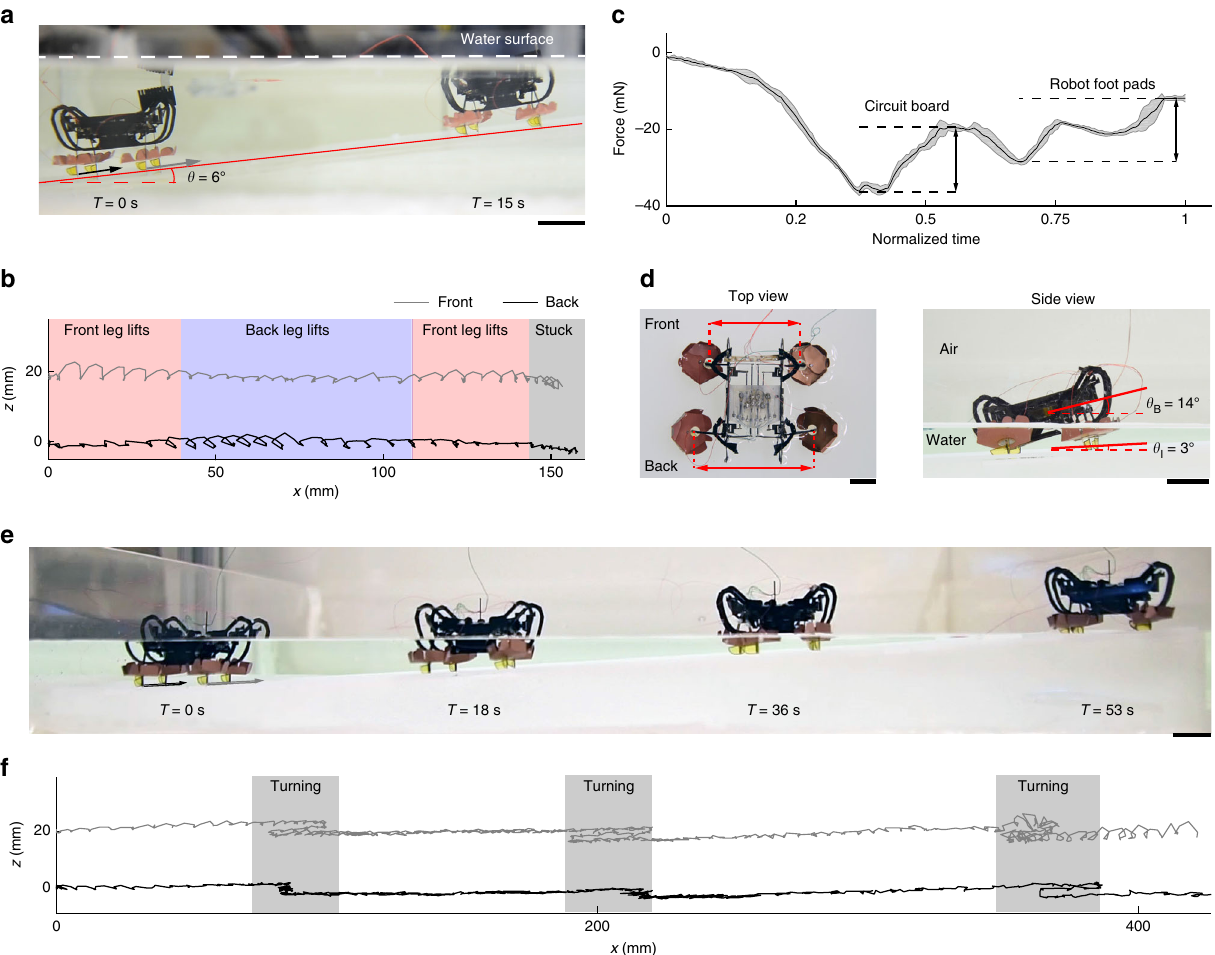
Fig. 6 Robot water to land transition. a The robot is stuck at the air-water interface as it climbs an incline from underwater. The surface tension force exerts a counter-clockwise torque on the robot body, preventing the robot hind leg from lifting off. b The trajectories of the robot ’ s front right and hind right legs. The ramp incline is subtracted from the trajectories to show leg lift at each step. When the robot is stuck, its hind legs cannot lift off the incline surface. c The net force on a robot as it is pulled out of water vertically. The net surface tension force exceeds the robot weight. d Top and side view images of a robot getting stuck at the air-water interface. The robot hind legs splay outward due to larger surface tension force on the rear of the robot. e After stiffening robot transmission in the lift DOF, the robot moves through the air – water interface on a 3° incline. f Robot leg trajectories during the water to land transition. The ramp incline is subtracted from the trajectories. During the transition process, the lift motion of both robot front and hind legs are reduced due to the inhibiting surface tension force. The robot leg motion recovers after the robot exits the surface of water. Scale bars ( a , d , e ), 1